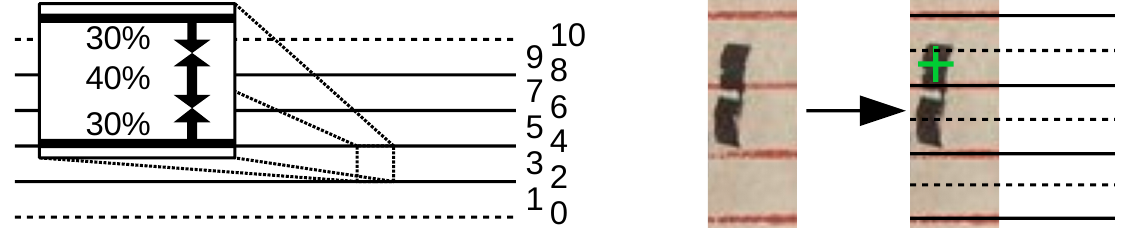
Figure 9. The left image shows the relative staff line positions shown on the right. The zoomed window marks the area sizes that are assigned as line or space, while the dashed lines indicate ledger lines. The right image is an example for a NC (green mark) that is visually closer to the space (dashed) however actually a NC on a line